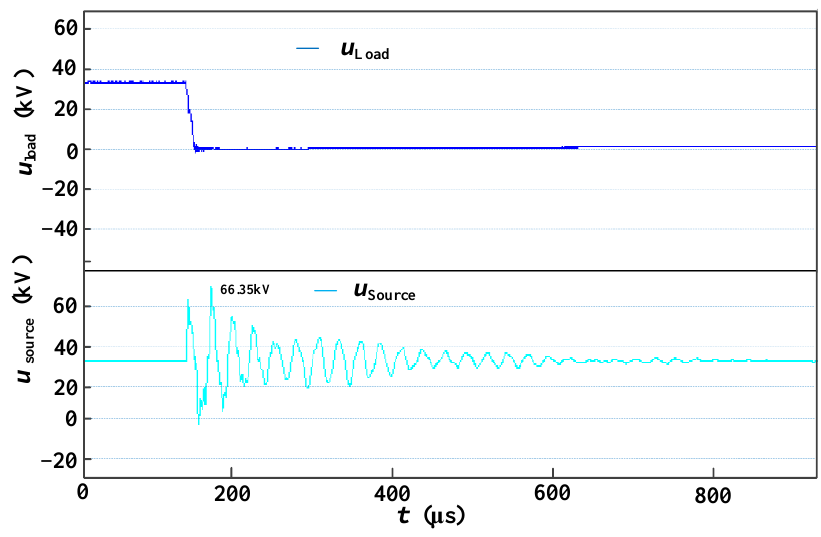
Figure 20. Oscillation process of overvoltage.